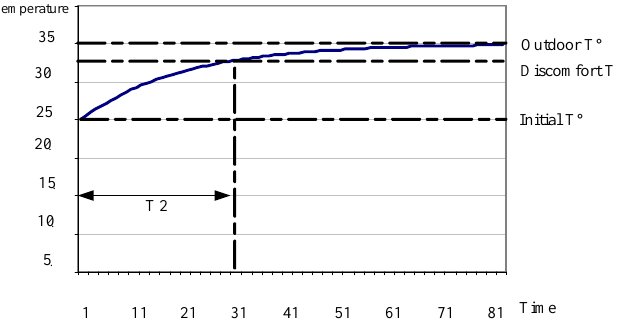
Figure 7. Typical cooling load off cycle during T2 time till discomfort level.